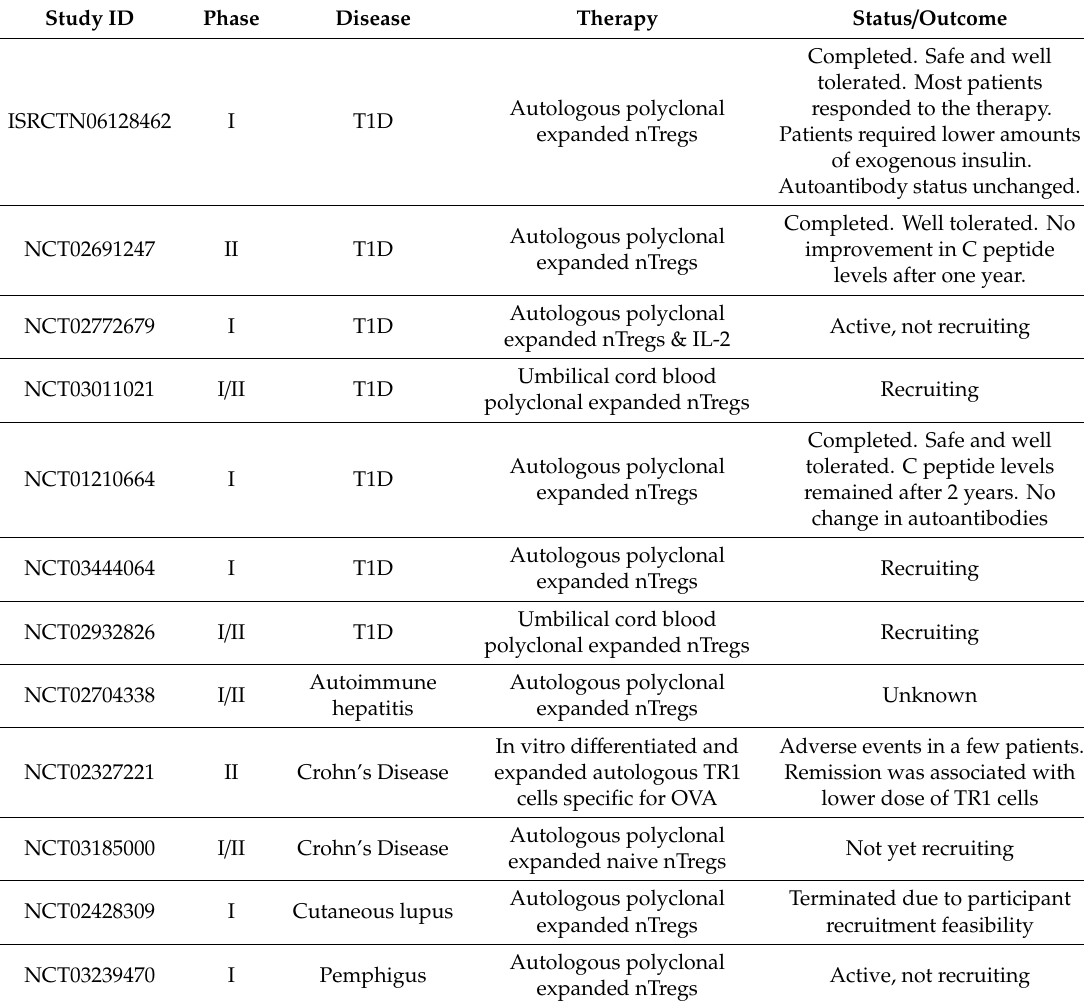
Table 1. Clinical trials using Tregs to treat autoimmune